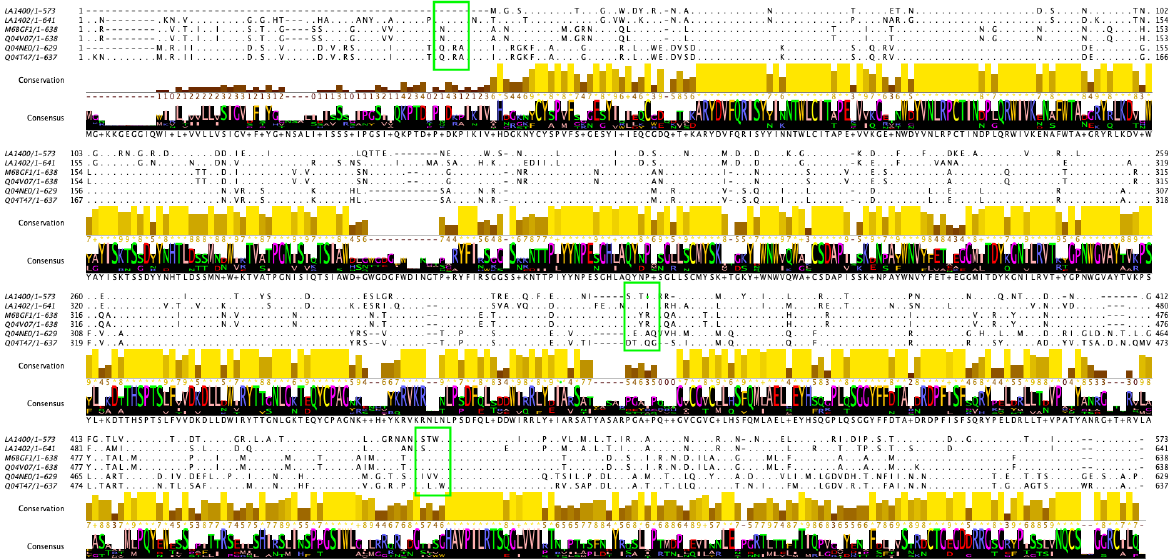
Figure 2. Multiple alignments for consensus, conservation, and direct differences were performed with Jalview [47] using amino acid sequences of L. interrogans Lai and L. borgpeterseni VM proteins. Legend: The green box shows highlights os similarities and differences in the amino acids of different strains of Leptospira.